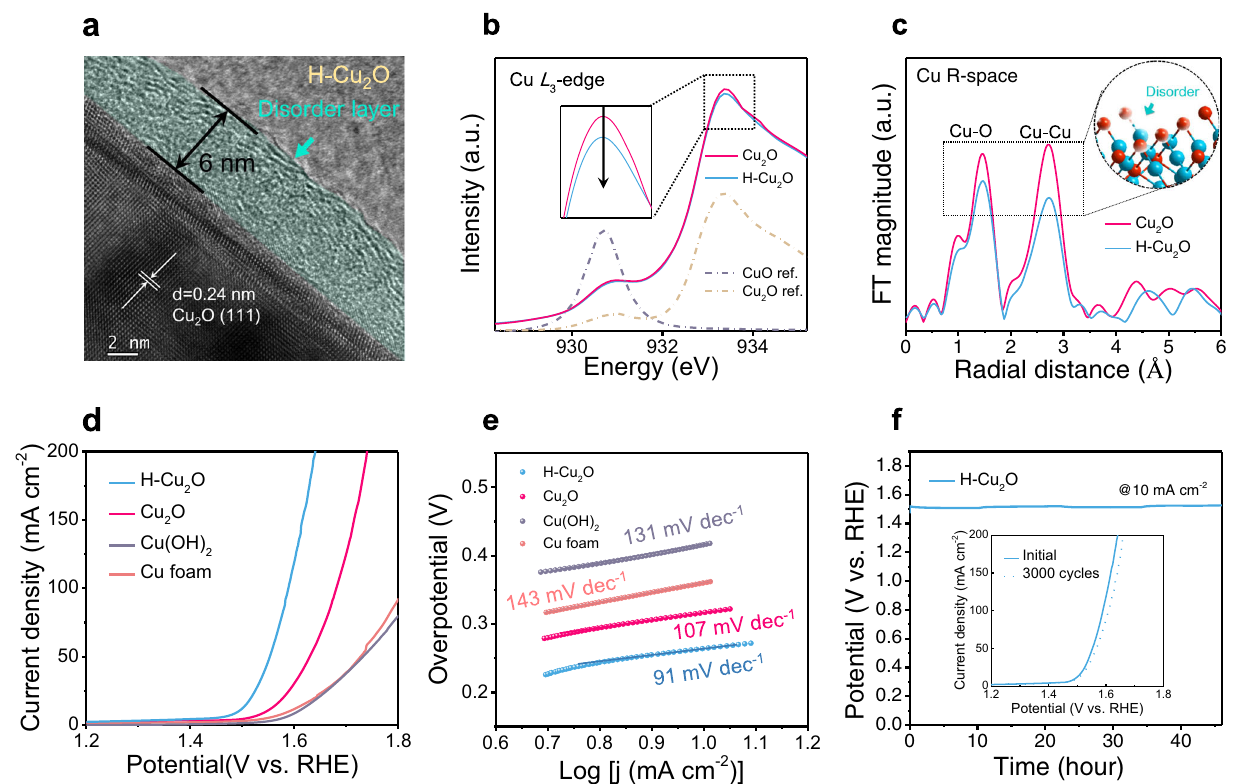
Fig. 1 | Structural characterization and OER performance of H-Cu 2 O catalysts. a TEM image of H-Cu 2 O. b Cu L 3 -edge XANES spectra of Cu 2 O, H-Cu 2 O and refer- ences (ref.). c Cu K -edge EXAFS spectra of Cu 2 O and H-Cu 2 O. d OER polarization curves of Cu 2 O,H-Cu 2 O,Cu(OH) 2 , and Cufoamin 1.0M KOH solutionwith 90%iR-